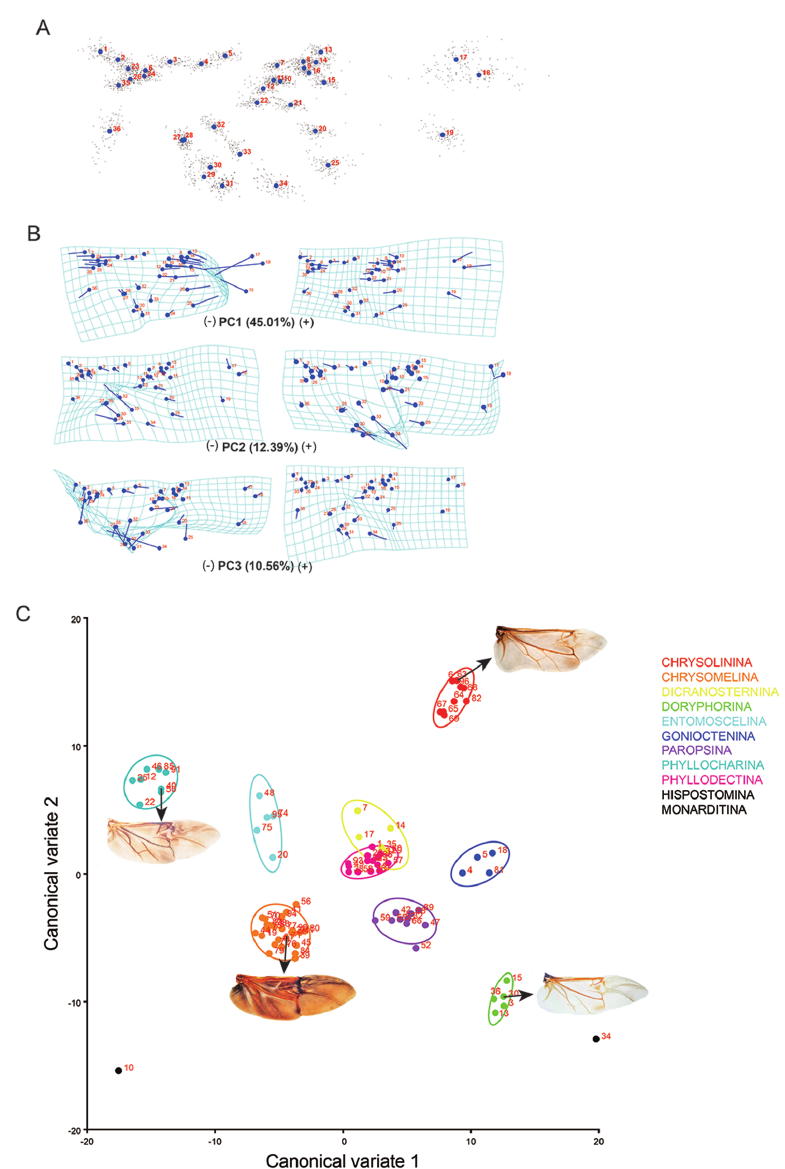
Figure 2. PCA and CVA results. A Centroid size graph of hind wing landmarks (Procrustes fit) B PCA results, the shape changes associated with the first three PCs: the relative size of the apical area which could be considered the main feature (variance contribution ratio was 45.01%) to influence of the overall variance of the hind wing, the changes of cross vein cv in the middle area (variance contribution ratio was 12.39%), and relative size of the anal area size (variance contribution ratio was 10.56%) C CVA results, the axis of CV1 and CV2 presented the first two large shape variance of all variance; points with different colours indicated different subtribes’ specimens; the ellipse is presented as an equal-frequency ellipse with a given probability level of 90%, which contains approximately 90% of the data